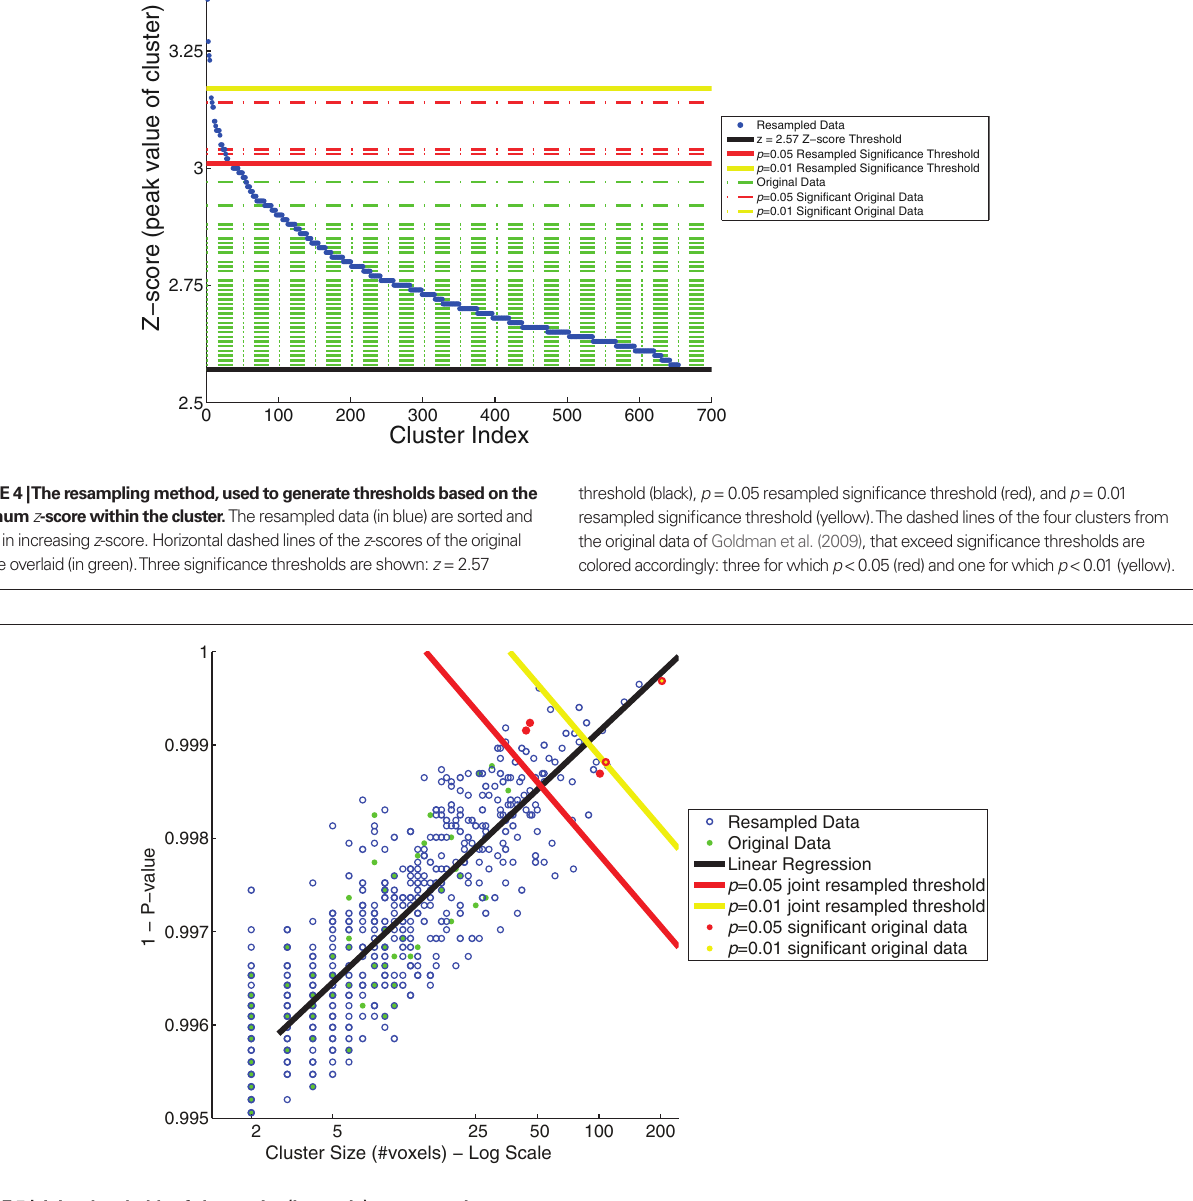
thresholds are shown: p = 0.05 resampled significance threshold (red), and p = 0.01 resampled significance threshold (yellow). Those clusters from the original data that exceed the joint significance thresholds are colored